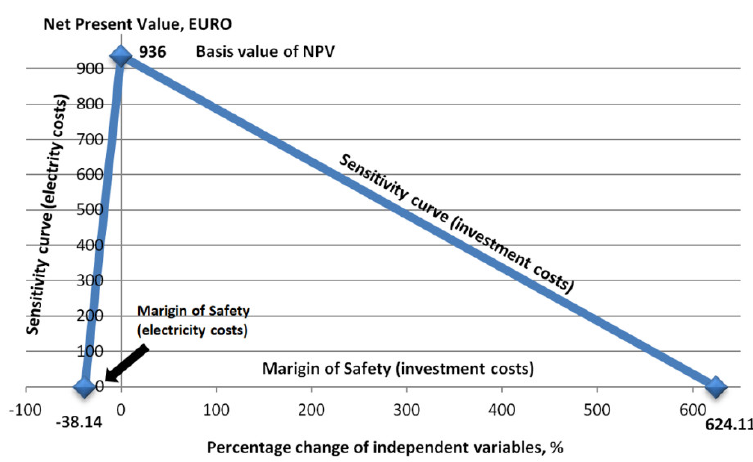
Figure 11. Graphic form of sensitivity analysis for variables that linearly change the profitability of HE_1 heat exchanger investments in Scenario A, Variant I and a 60 min shower time.